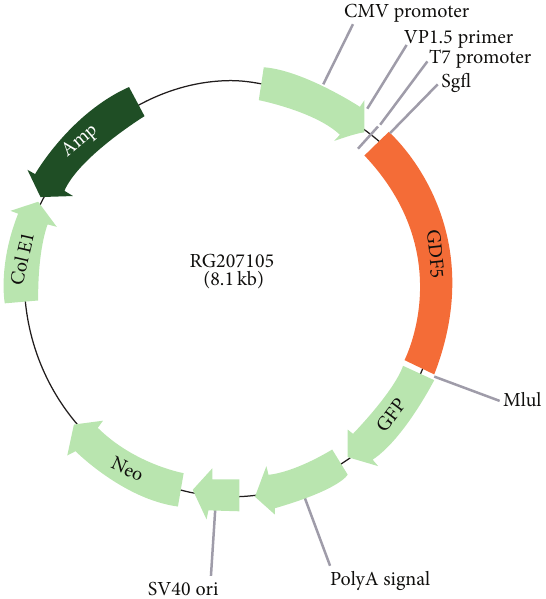
Figure 1: Plasmid map of pCMV6-AC-GFP vector containing the true gold ORF of human GDF5 (GenBank accession number NM 000557) with C-terminal